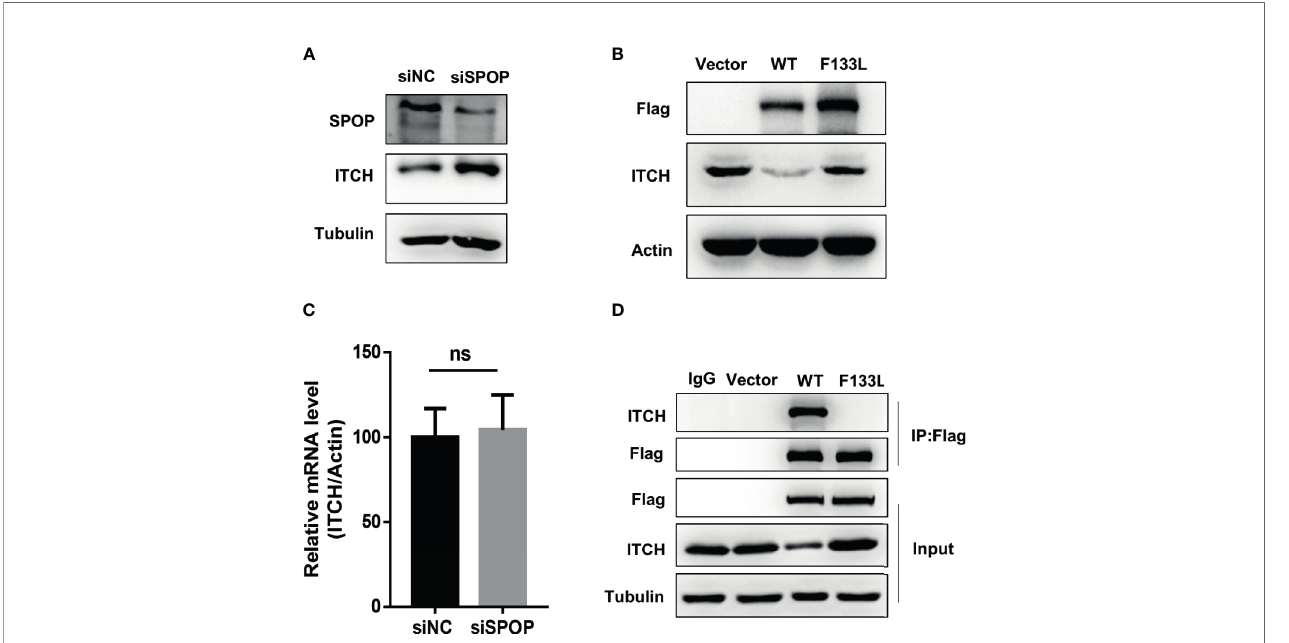
FIGURE 1 | SPOP interacts and downregulates ITCH. (A) Protein expression of lysates derived from LN-CaP cells transfected with either a control or SPOP -siRNA, measured by Western blot. (B) Protein expression of lysates derived from LN-CaP cells transfected with an empty vector, the wild type or F133L mutant form of SPOP, measured by Western blot. (C) ITCH ’ s mRNA expression in the transfected cells, measured by RT-PCR. (D) Interaction of SPOP and ITCH was assessed by co-immunoprecipitation of lysates derived from PC-3 cells expressing empty vector, the wild type or F133L mutant SPOP using IgG or the anti-Flag antibody. Membranes were probed with the indicated antibodies. ns, no signi fi